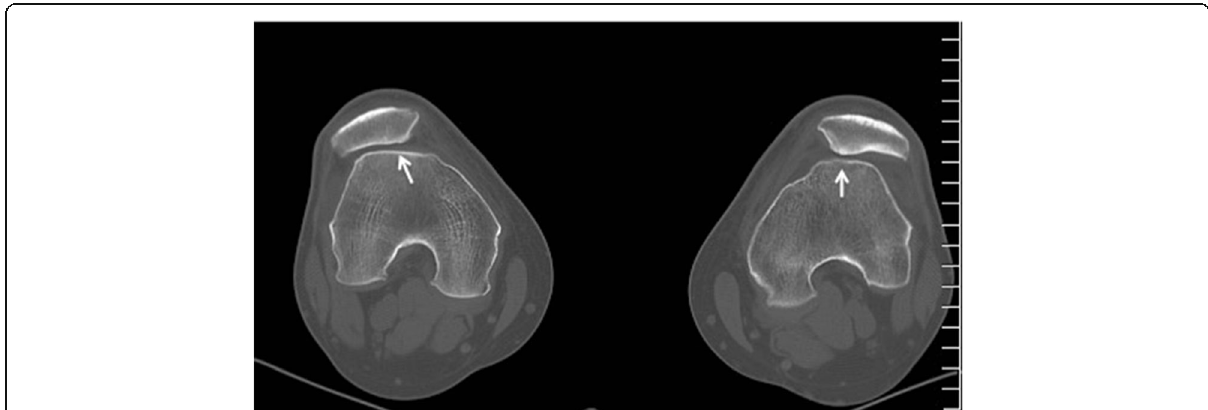
Fig. 8 CT of both knees in 20° flexion demonstrating bilateral shallow trochlear groove (arrows) compatible with dysplasia and bilateral lateral patellar subluxation and lateral tilt. The two features are associated with patellar